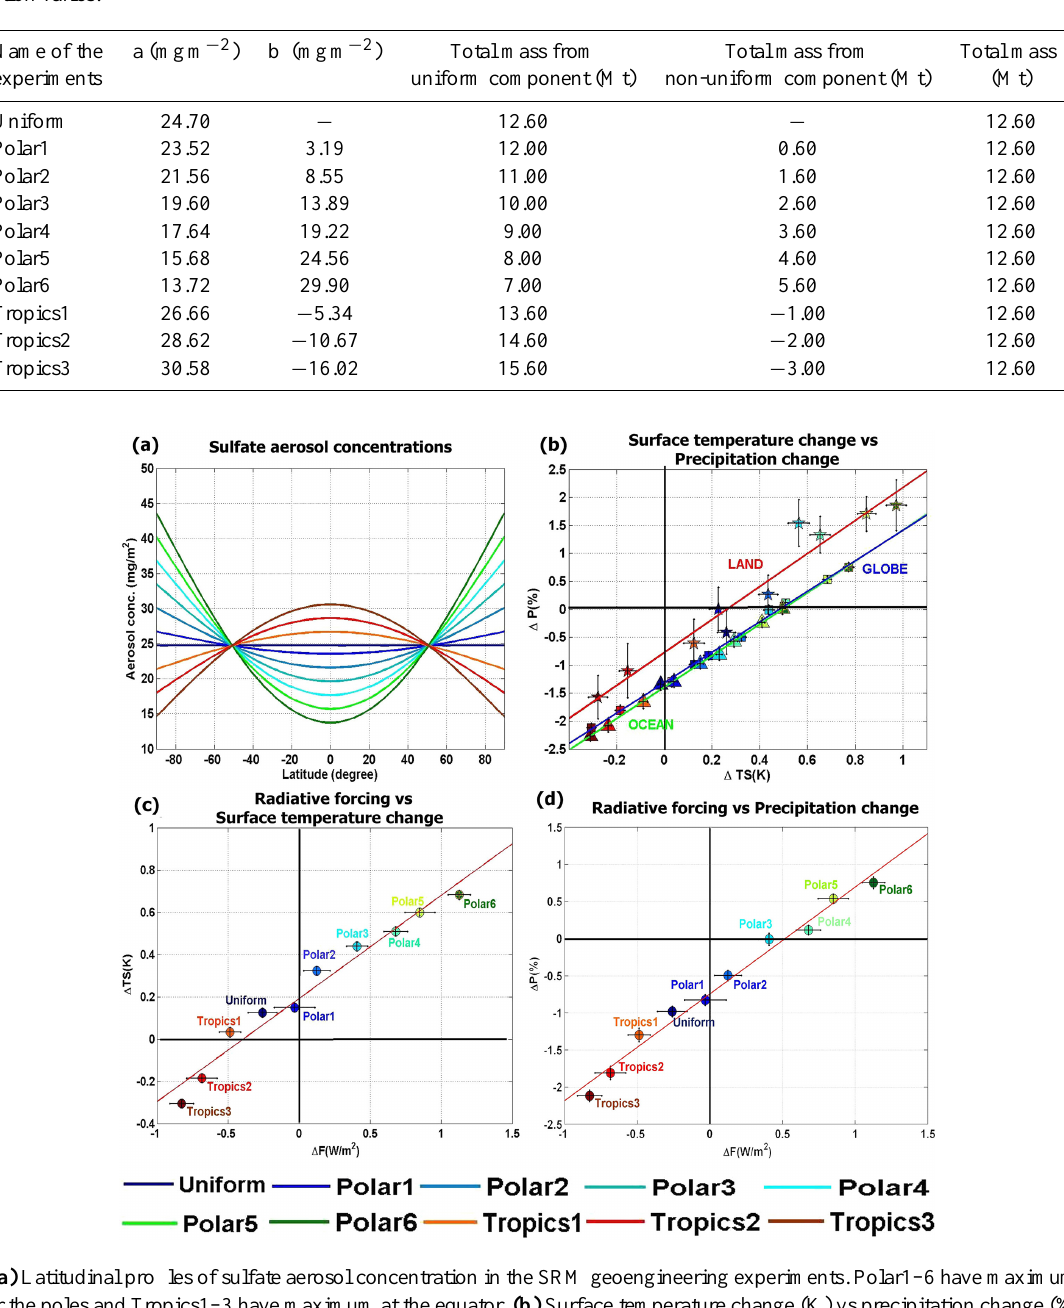
Table 1. Description of different geoengineering experiments. Total additional mass is 12.6MtSO 4 in all the geoengineering simulations but the distribution varies.